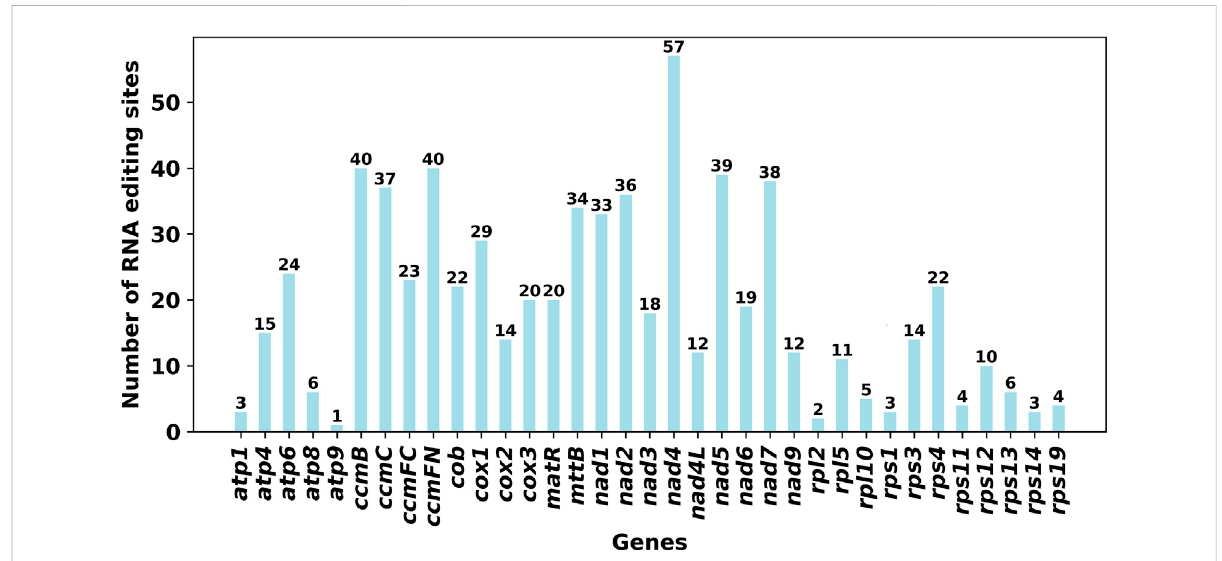
FIGURE 4 Number of RNA editing sites predicted by individual PCGs in